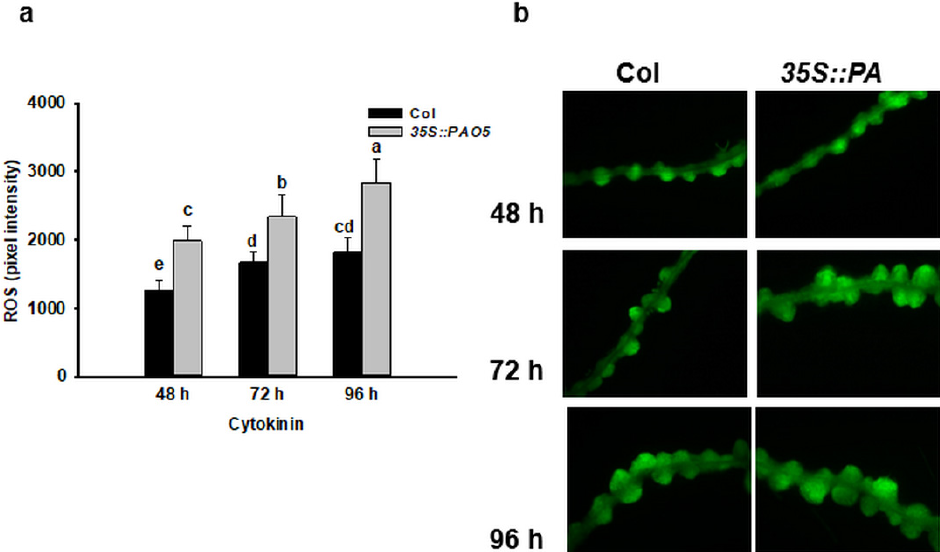
Figure 6. ROS level influenced by 35S::PAO5 expression correlates with the process of direct shoot meristem formation. Representative diagram ( a ) and images ( b ) of 2,7-dichlorodihydro-fluorescein diacetate (H2DC-FDA)-derived DCF fluorescence in WT (Col) and transgenic (35S::PAO5) seedling roots after 48, 72 and 96 h cytokinin treatment representing the organ conversion (48 h), the early (72 h) and late (96 h) shoot promeristem phases [7]. Scale bars = 100 µm. Data are means ± SE of three biological replicates with twenty technical replicates each. Different letters indicate significant differences of Duncan’s multiple comparisons ( p < 0.05).